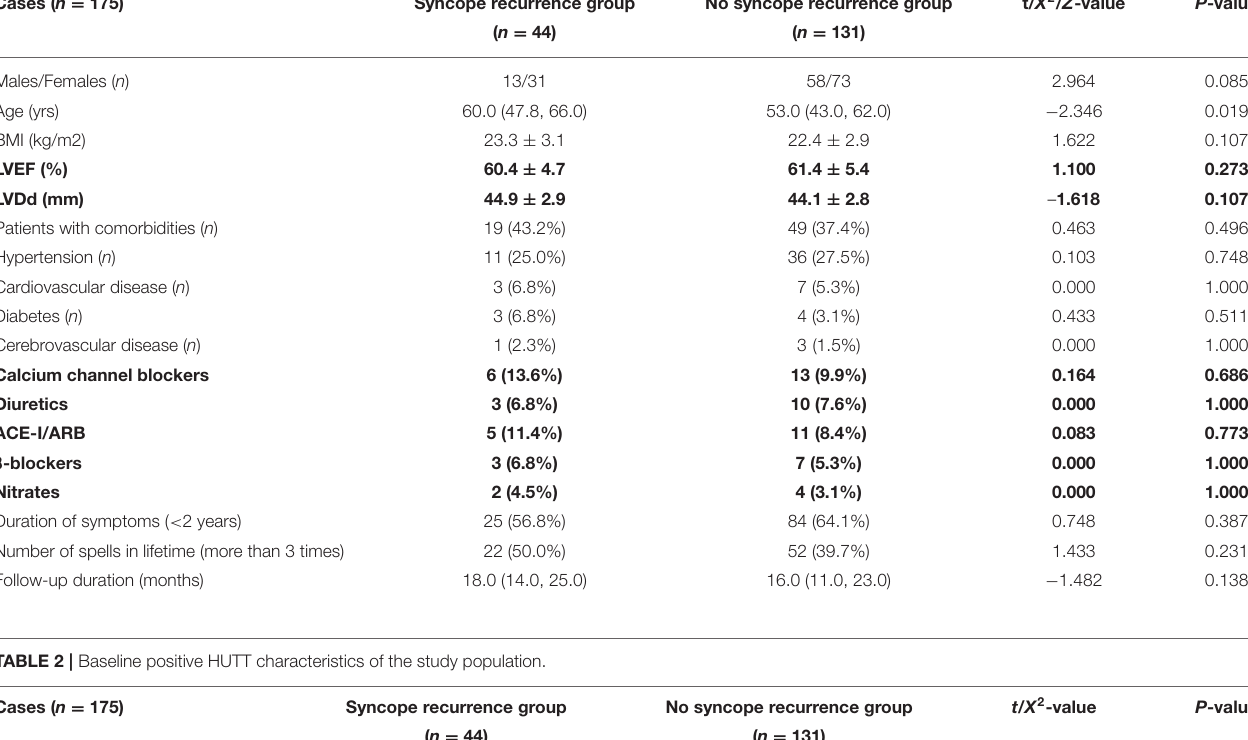
TABLE 1 | Baseline characteristics of the study population and follow-up duration.